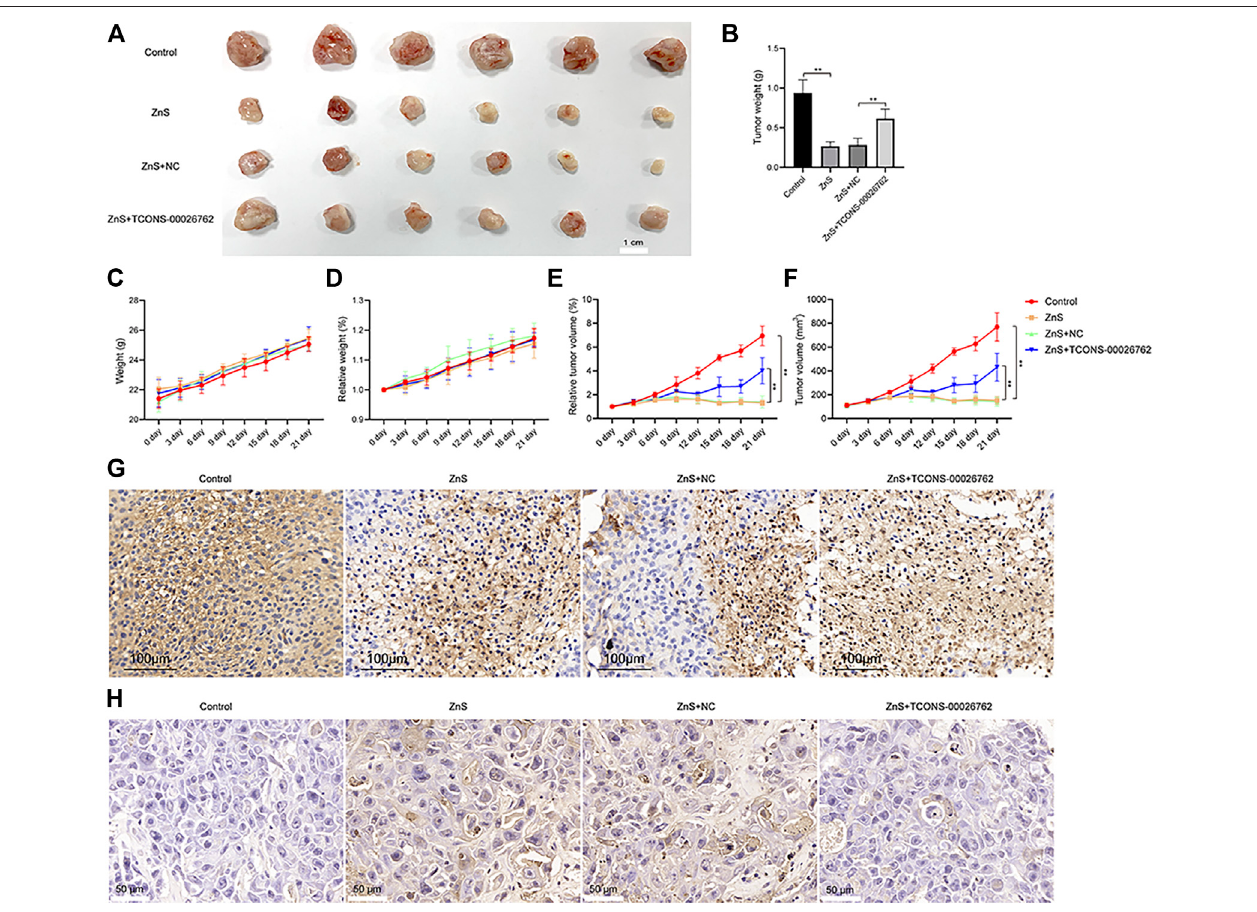
FIGURE 4 | The inhibitory effect of ZnS and TCONS-00026762. (A) SMMC-7721 cells were subcutaneously injected into the right fl ank of nude mice to establish tumors.Scalebar,1 cm. (B) Thetumorweightmeasured (CandD) Theweightandrelativeweightofnudemiceweremeasured (EandF) Thetumorvolumeandtumor relativeweightweremeasured (G) Immunohistochemicaldetectionofki67expressionintumortissue.Scalebar,100 μ m (H) Theapoptosisoftumortissuewasanalyzed by TUNNEL. Scale bar, 50 μ m. Error bars represents mean ± SD, **, p <